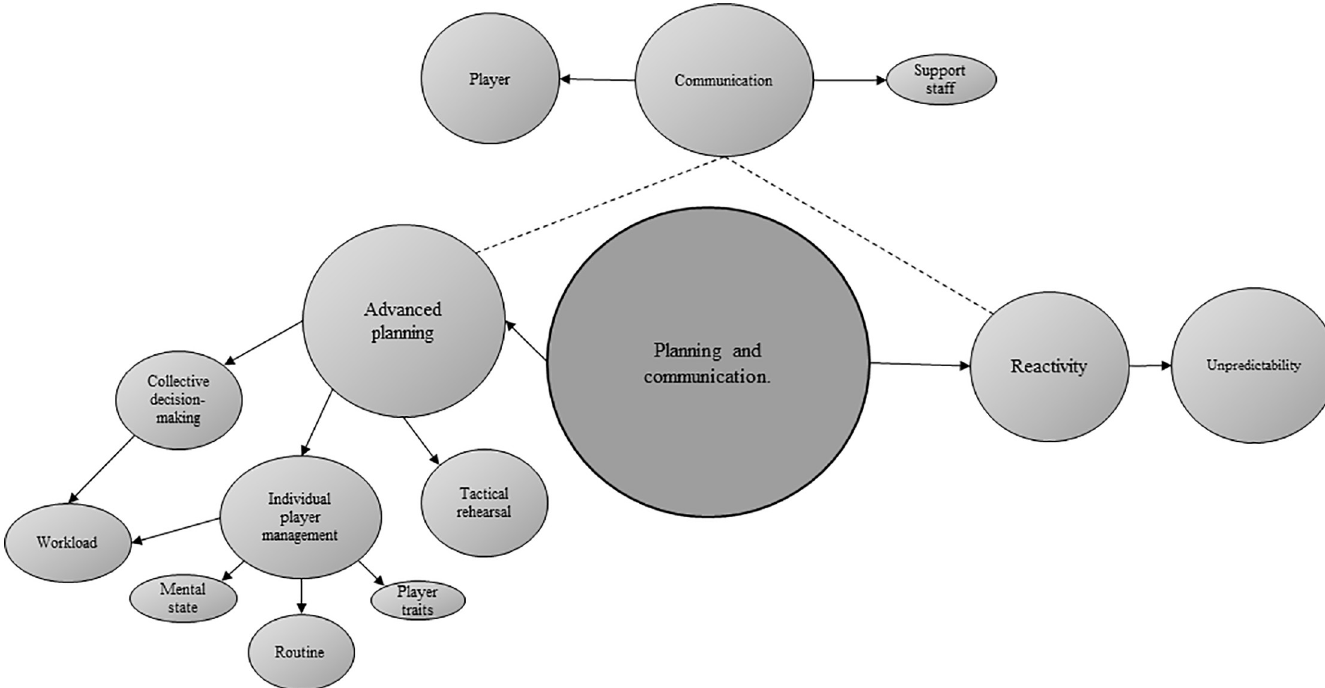
Fig 2. Thematic emergences depicting tactical practitioner responses concerning planning and communication (n = 7). Prevalence is indicated by size.